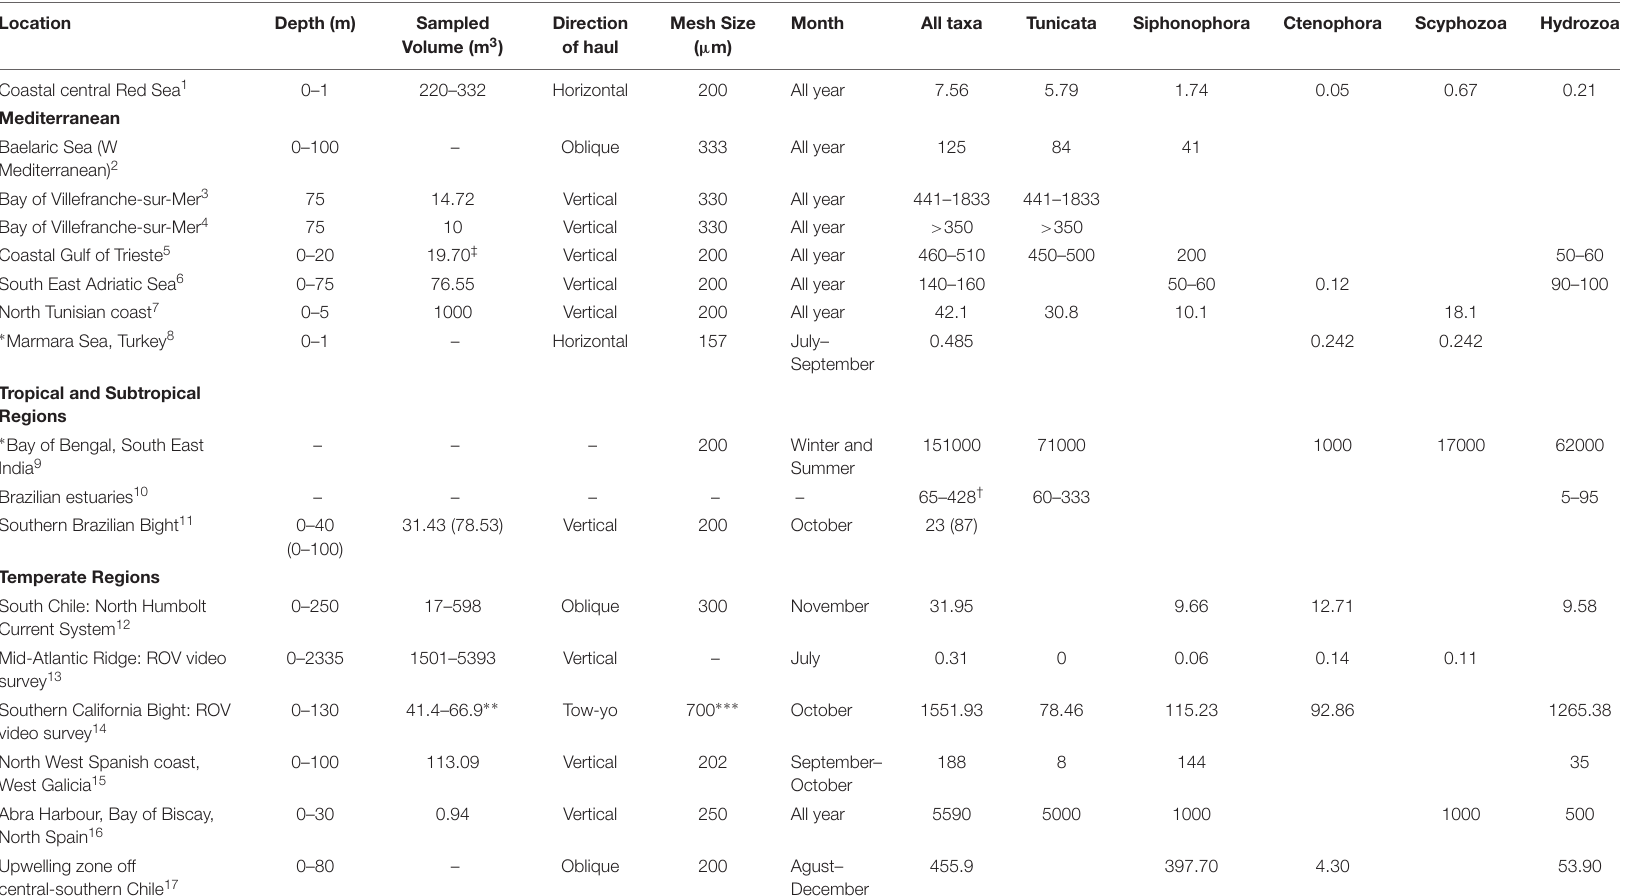
TABLE 1 | Summary of studies on gelatinous zooplankton communities comparing maximum abundance (ind. m − 3 ) of the all taxa sampled, and the maximum abundance found for each of the groups considered in this study.